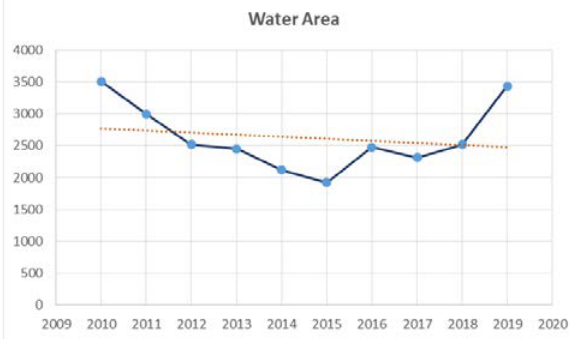
Figure 4. Trend of water level during 10 years